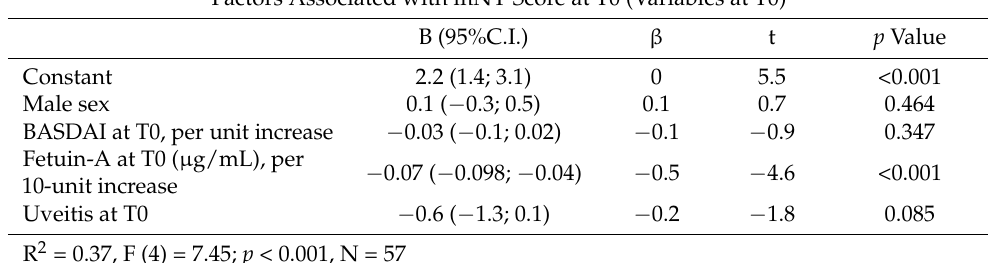
Table 3. Multivariate analysis of factors associated with mNY score at T0 and at T24, results of multiple regression